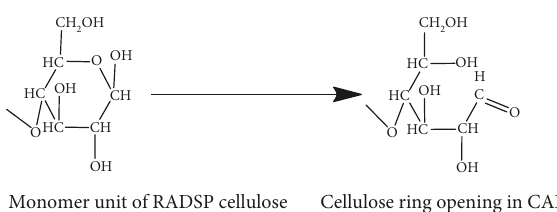
Scheme 1: Mechanism of charring of RADSP to give CADSP [26, 60].